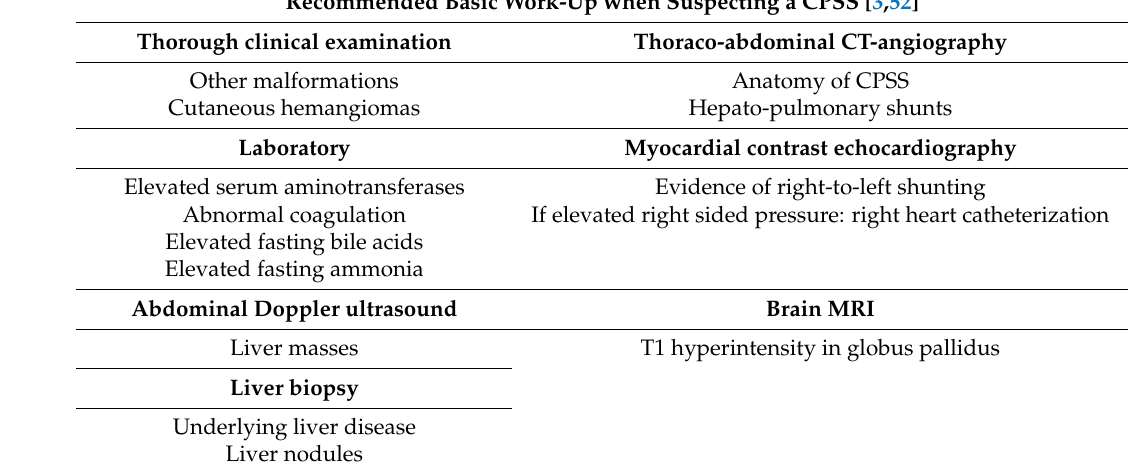
Table 4. Purpose of recommended basic work-up in suspected